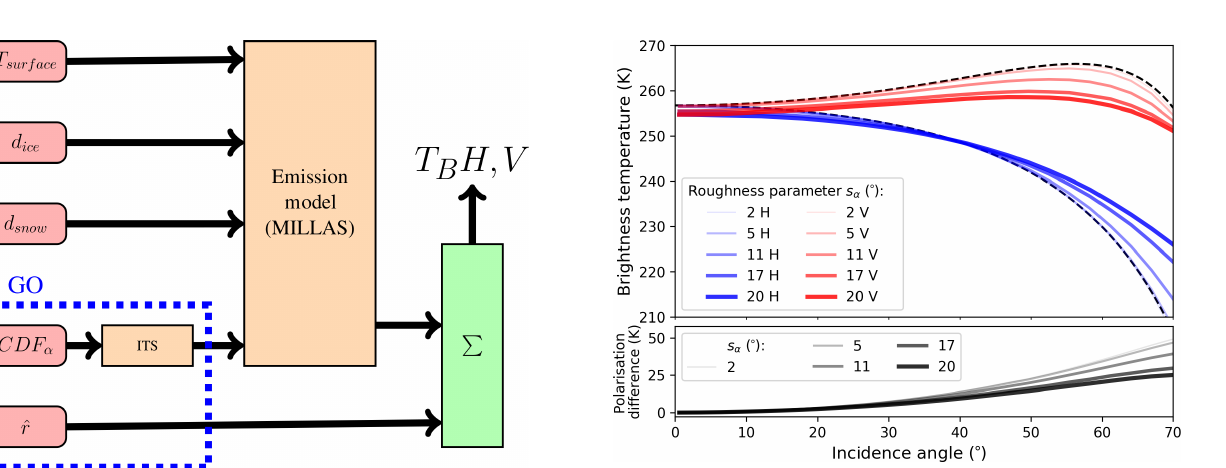
Figure 6. Flow chart showing the processing chain within the ge- ometrical roughness model. The model consists of two principal blocks: the emission model and the inverse transport sampling ITS module responsible for generating the facet orientation. The input parameters surface temperature T surface , ice thickness d ice , snow thickness d snow , cumulative distribution of surface slopes CDF α , and antenna direction ˆ r are colour coded in red.